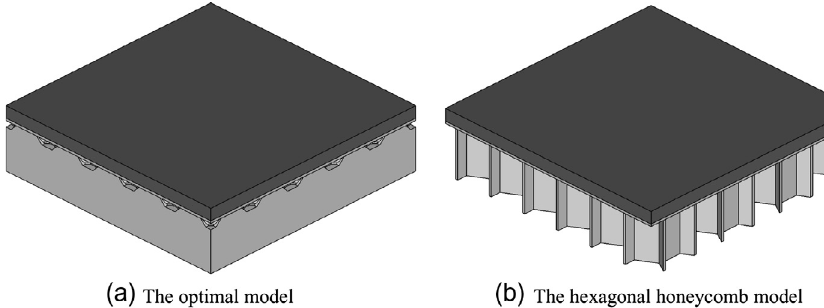
Figure 7. The optimal model and the hexagonal honeycomb model to be